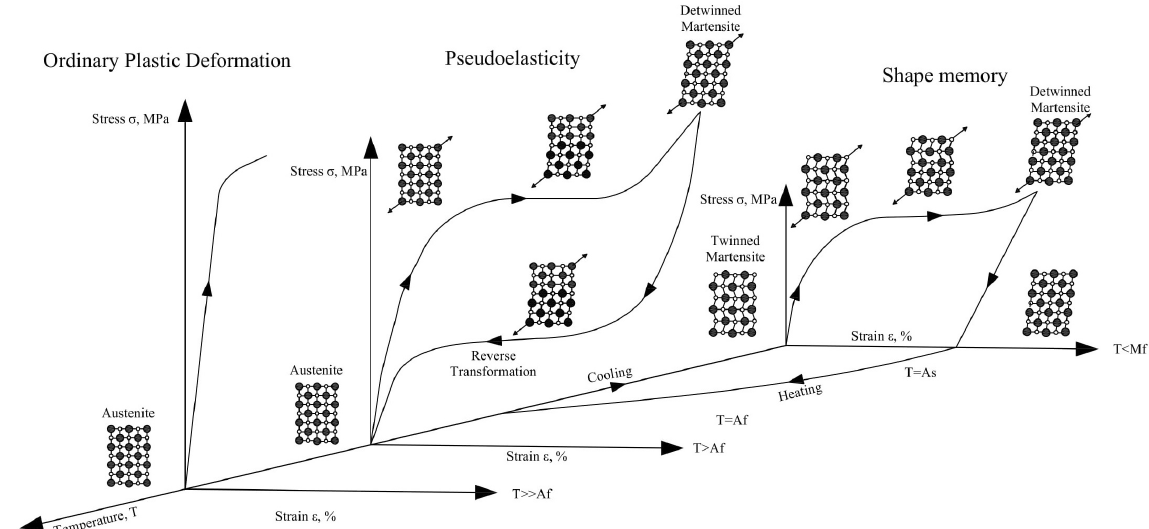
Figure 6. SMA stress–strain graphs depicting schematic crystal formations at different temperatures [26] (figure is taken from